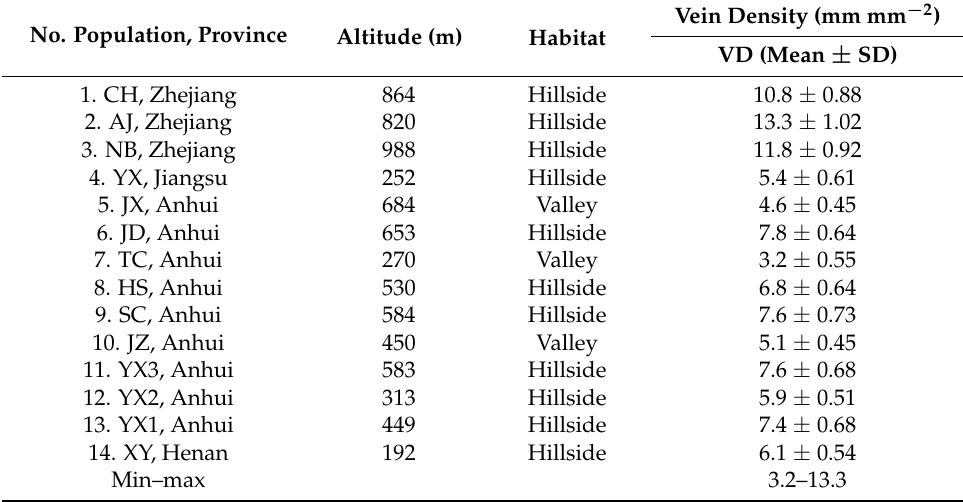
Table 4. Leaf vein density (mean ± Standard Deviation(SD)) of P. subaequalis by site examined in this study.